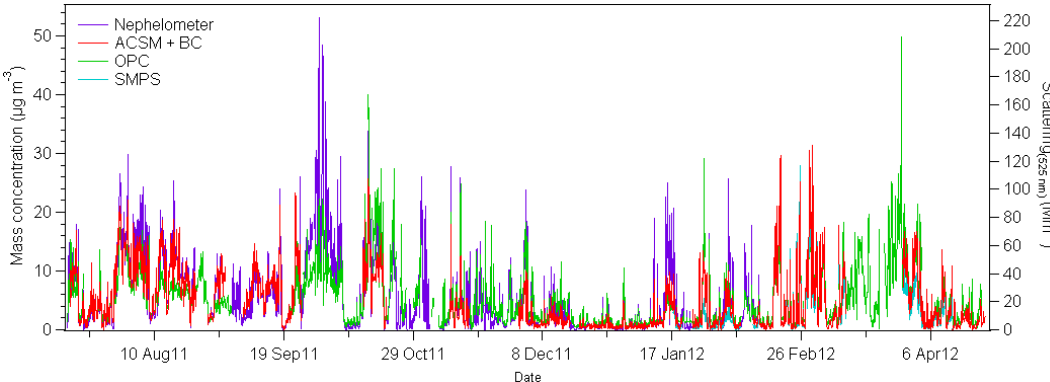
Figure 2. Time series of PM 1 total mass from co-located measurements and light scattering at